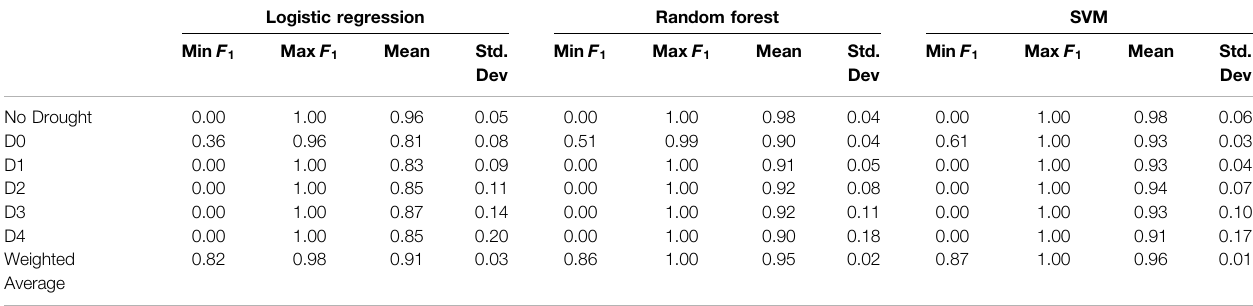
TABLE 7 | Descriptive statistics of the models performances using Group 4 input features over the entire domain. Logistic regression Random forest